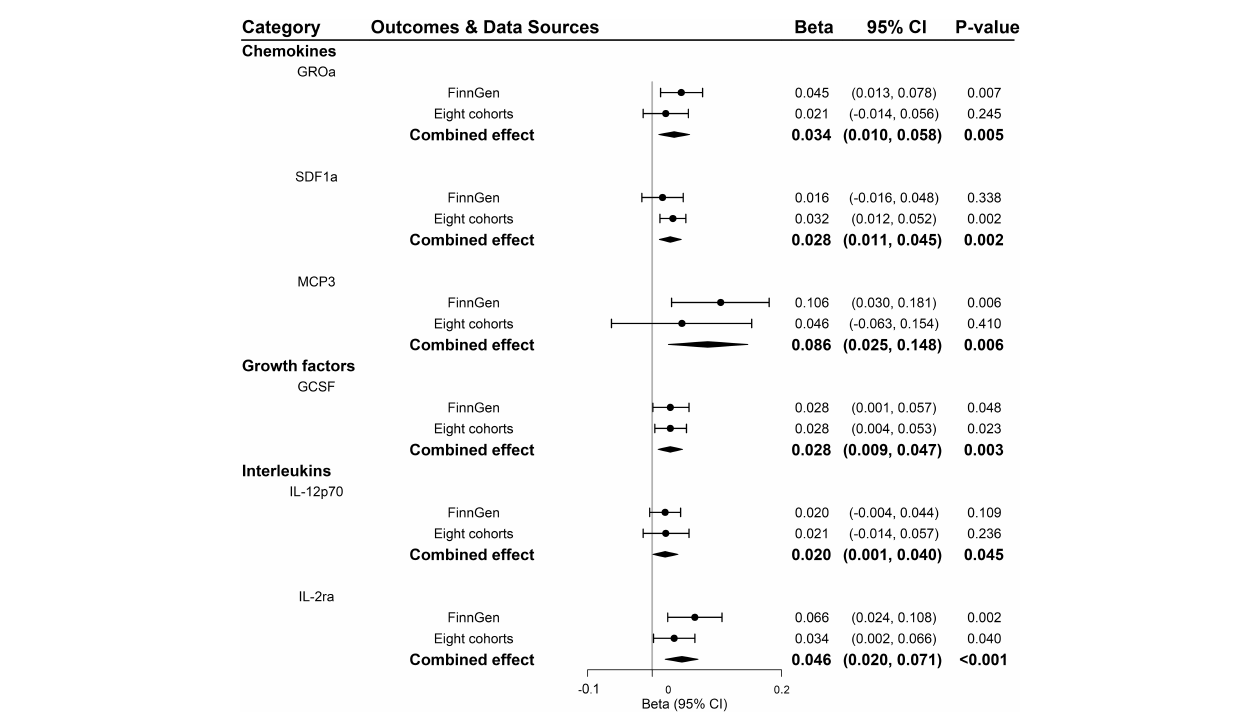
FIGURE 5 Signi fi cant associations between genetically predicted proliferative diabetic retinopathy and systemic in fl ammatory regulators. GCSF, granulocyte colony- stimulating factor; GROa, growth-regulated oncogene-alpha; IL, interleukin; MCP3, monocyte chemotactic protein-3; SDF1a, stromal cell-derived factor